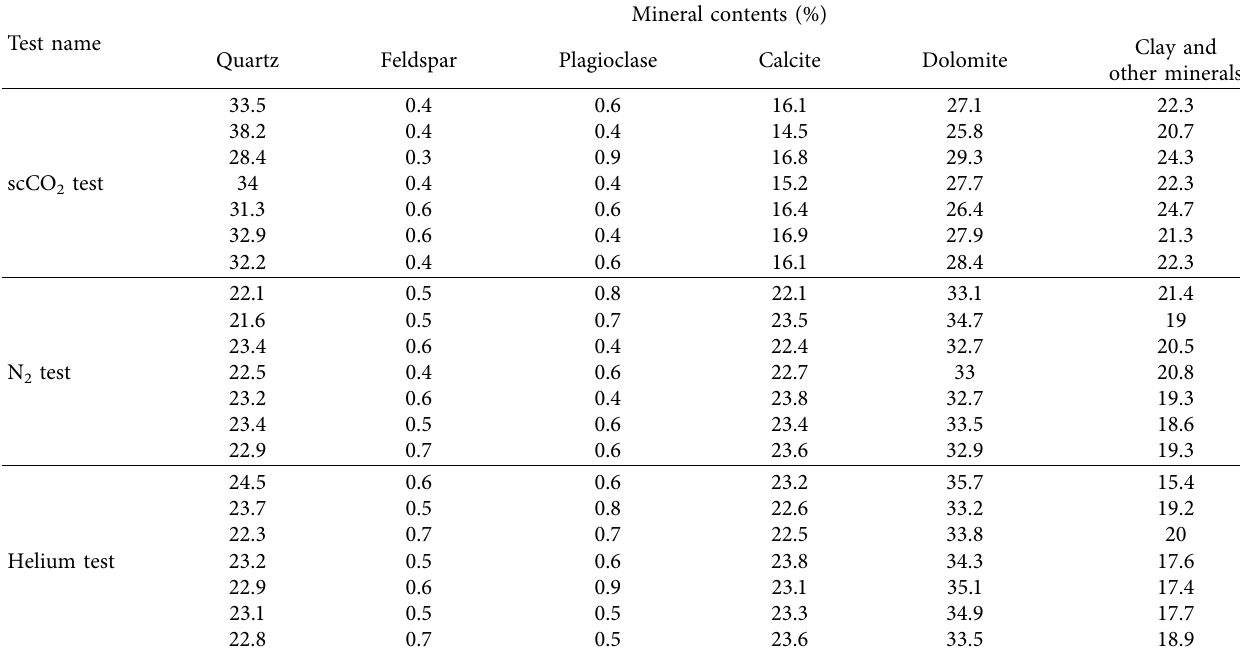
Table 4: Mineralogical analysis results of the three experiments